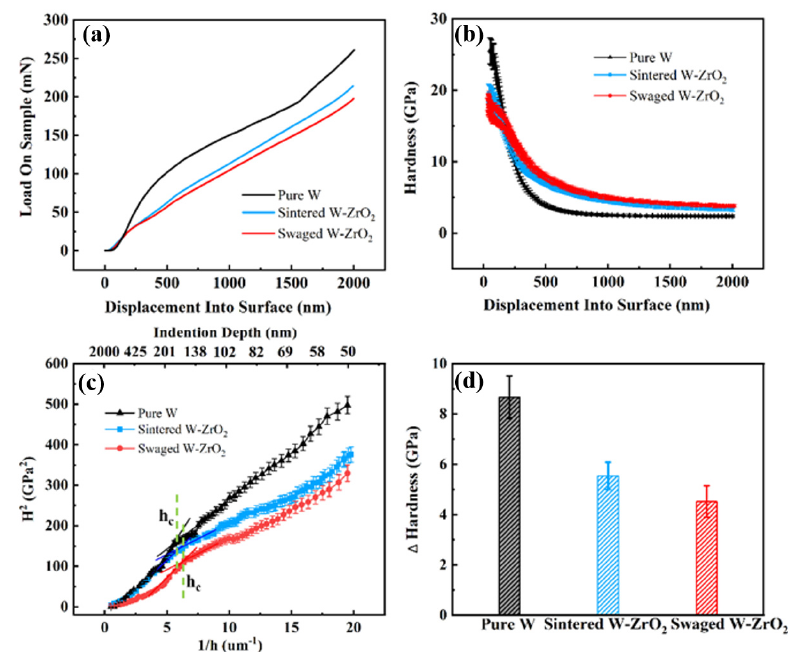
Figure 9. Irradiation hardening effect statistics of three irradiated samples: ( a ) load ‐ displacement curves, ( b ) corresponding hardness ‐ displacement curves, ( c ) the nanohardness curves as H 2 versus h − 1 , ( d ) experimental hardness values at h c depth (~150 nm).